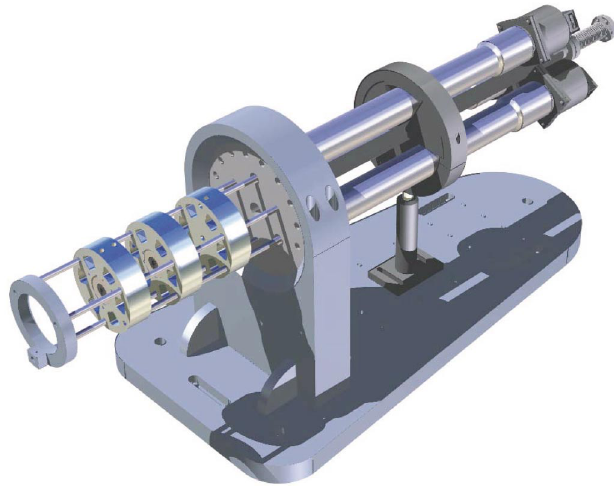
FIG. 14. (Color) Rendered CAD drawing of the final-focus